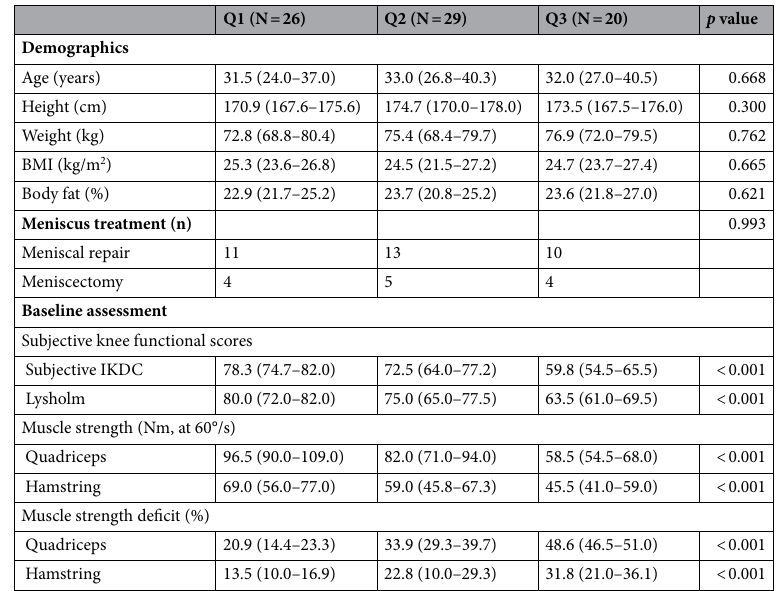
Table 1. Characteristics of the study participants at baseline. Group Q1: < 25% deficit in quadriceps muscle strength, group Q2: 25–45% deficit quadriceps muscle strength, and group Q3: > 45% deficit in quadriceps muscle strength, compared the uninjured limb. BMI body mass index, IKDC International knee documentation committee. Values are presented as median [IQR 25–75th percentile] if no otherwise specified.